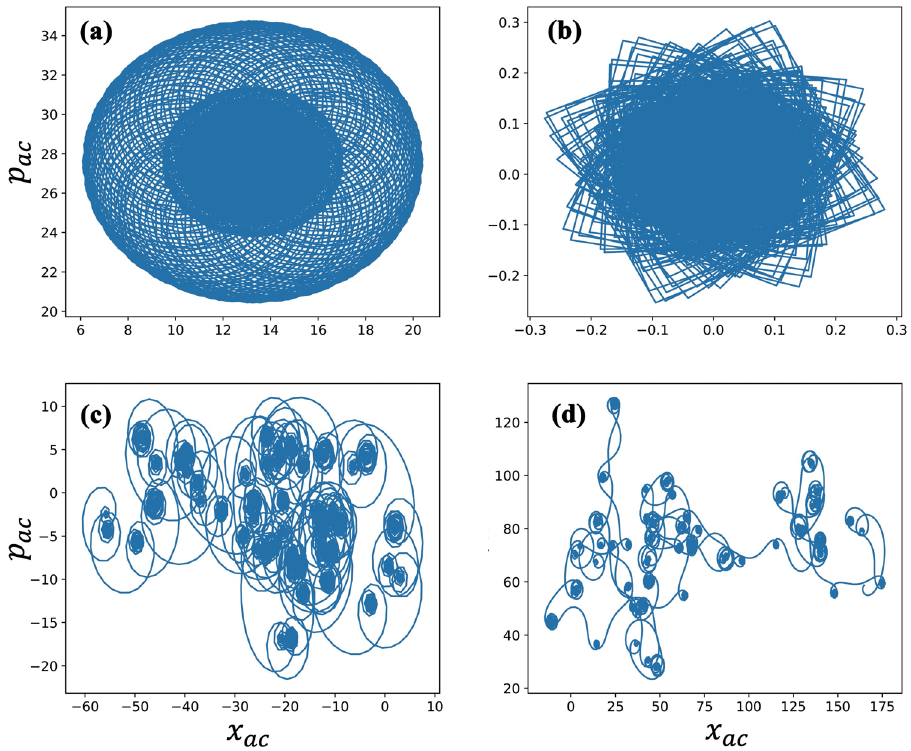
Figure 4. The dynamics of the translation components ( x ac , p ac ) . The parameters used are γ c /γ a = 0.5, γ m /γ a = 2, η/γ a = 5, V 0 /γ a = 20, V 1 /γ a = 40, ω r /γ a = 1, � c /γ a = − 1, and � a /γ a = − 2. We also used ( a ) g ac /γ a = 0.5, g mc /γ a = 2; ( b ) g ac /γ a = 2, g mc /γ a = 2.5; ( c ) g ac /γ a = 2, g mc /γ a = 2; and ( d ) g ac /γ a = 4, g mc /γ a =